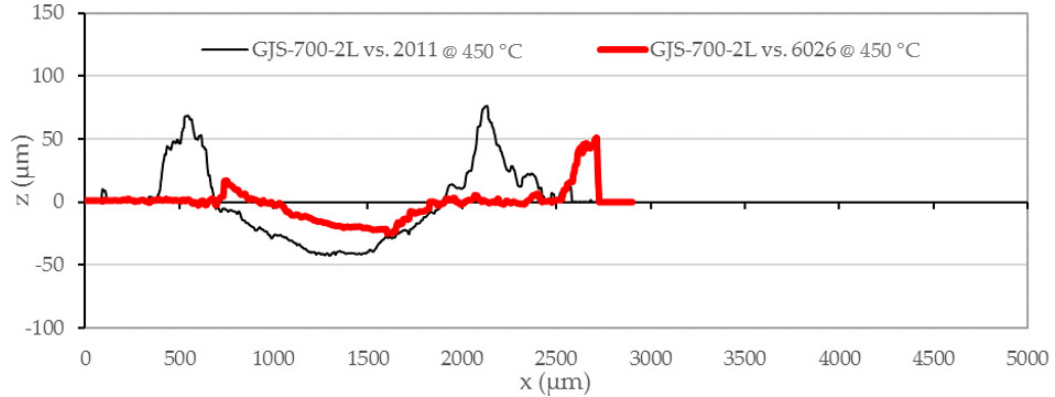
Figure 11. Depth profile of the track. Tests carried out at 450 °C with GJS-700-2L showing how wear rules over galling both with 2011 and 6026.